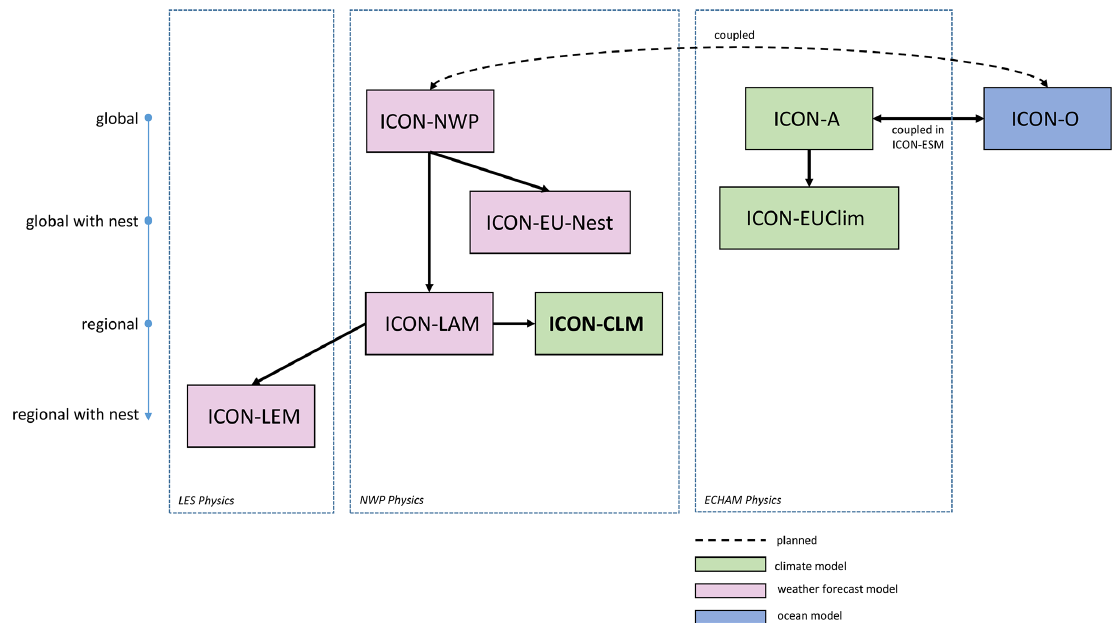
Figure 1. Overview of the ICON modelling framework.